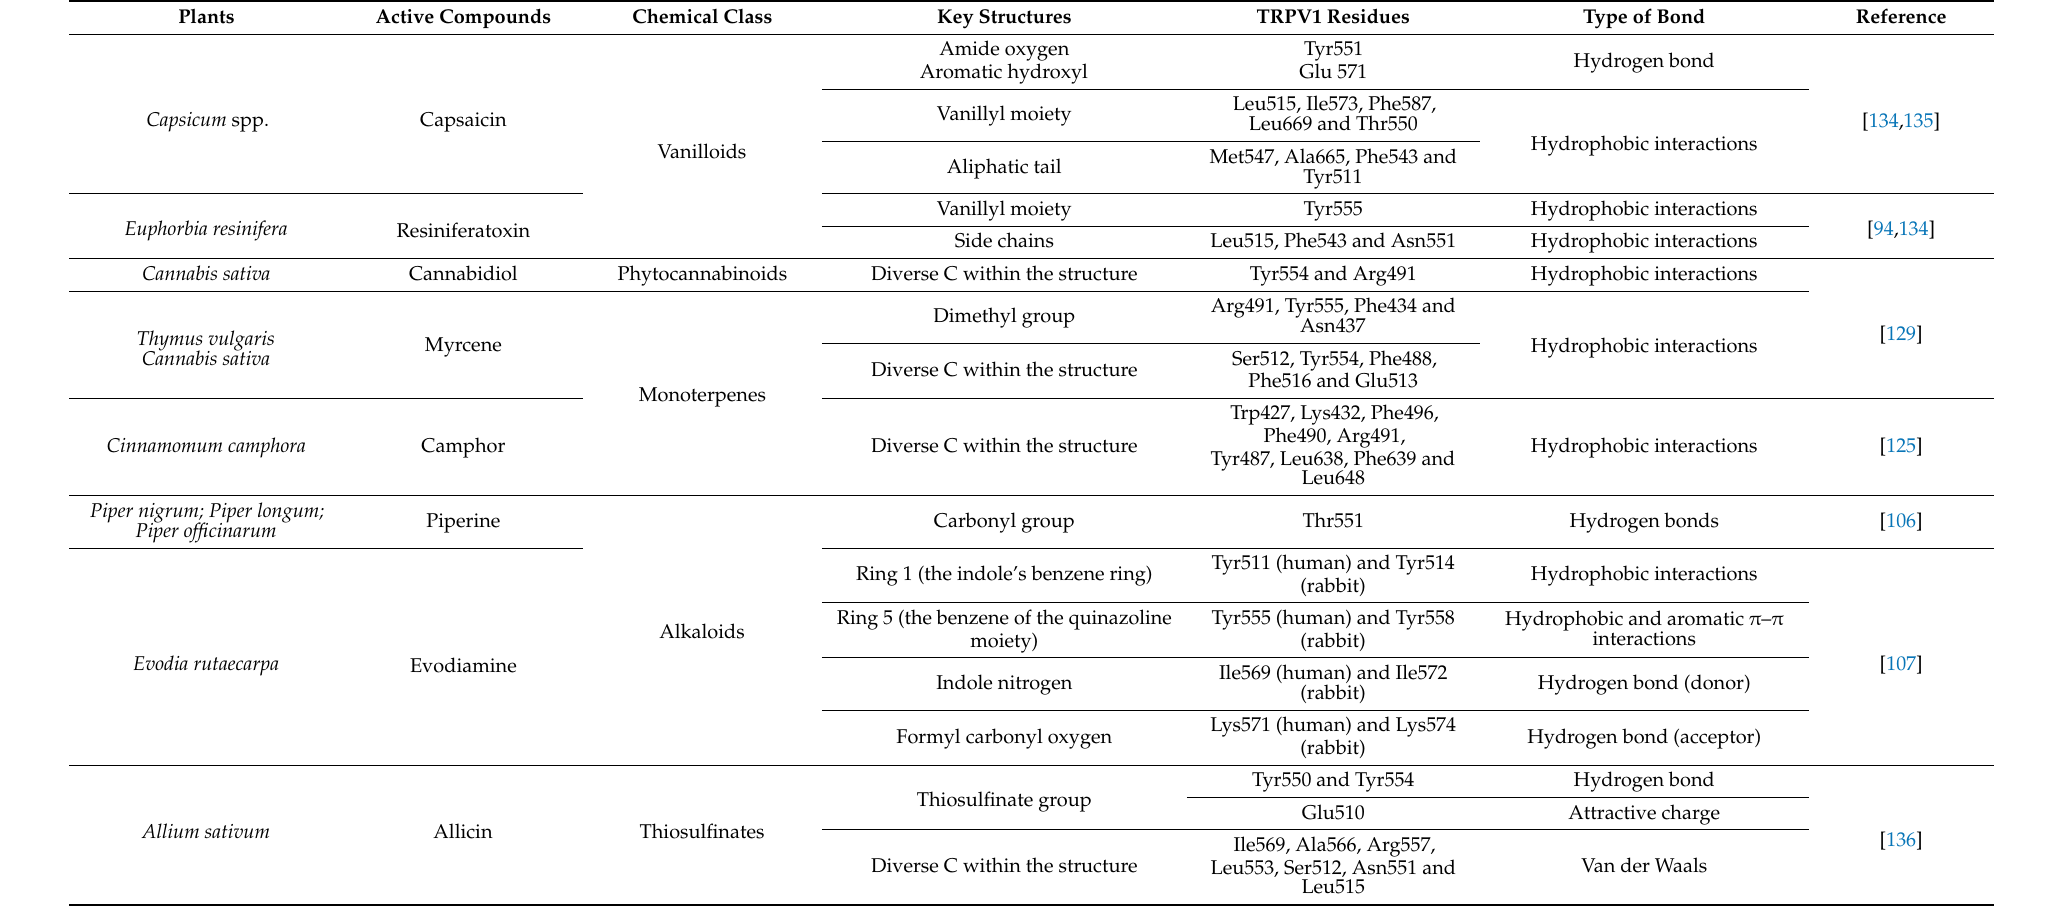
Table 1. Main interactions of TRPV1